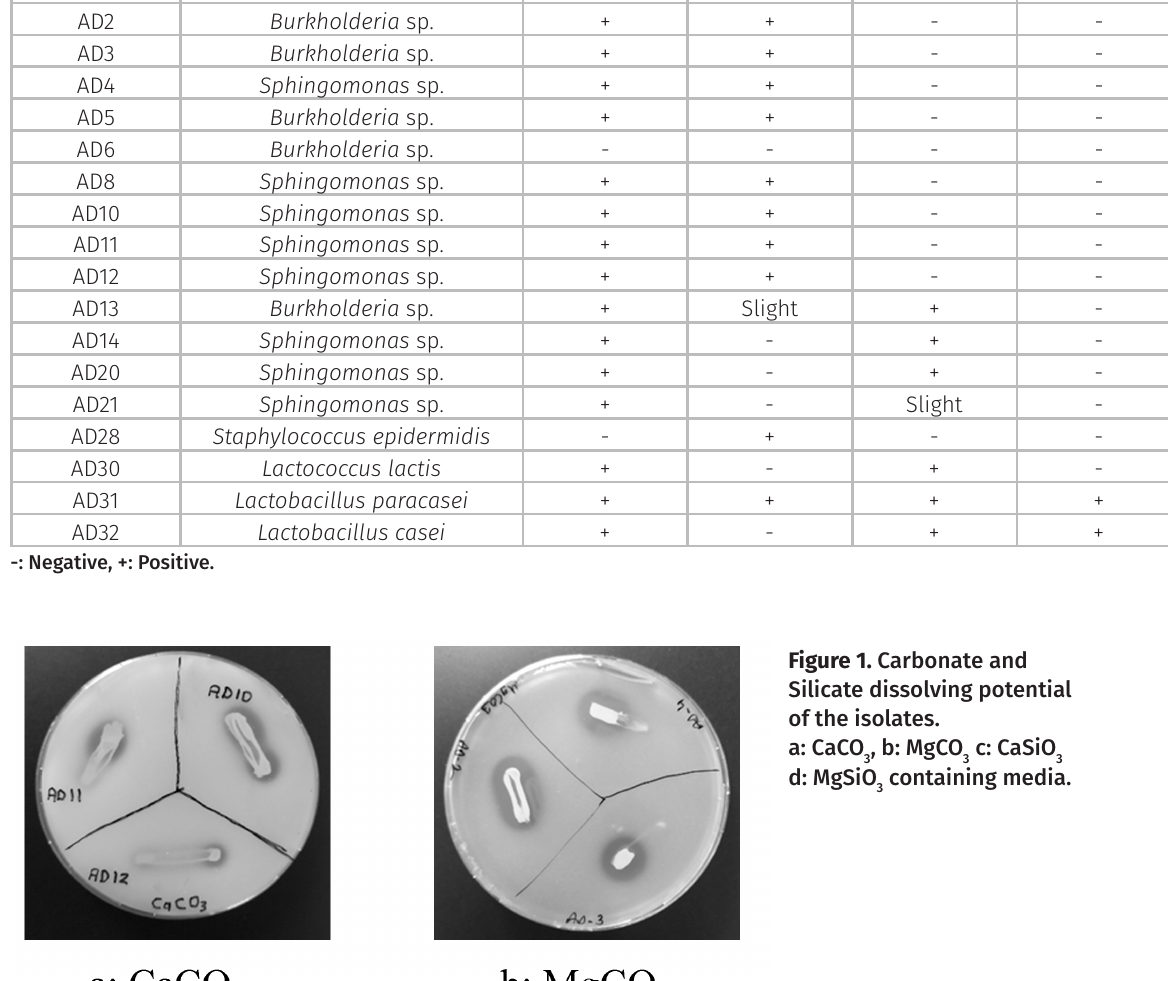
Table VI. Carbonates and Silicates dissolution potential of the isolates. Isolate code